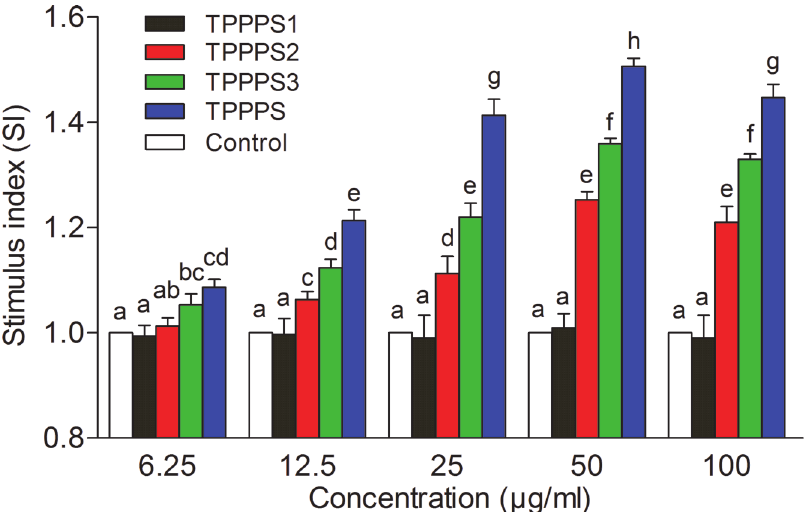
Fig 3. Effects of TPPPS1-3 and TPPPS on splenocyte proliferation in vitro . Splenocytes were isolated and cultured in 96-well plates. After ConA stimulation, the proliferation was examined by MTT method as described in the Materials and Methods. Stimulus index represents the ratio of absorbance between the experimental group and control group, and the values are presented as mean ± SD from five independent experiments. Different superscripts indicate a significant difference ( P <